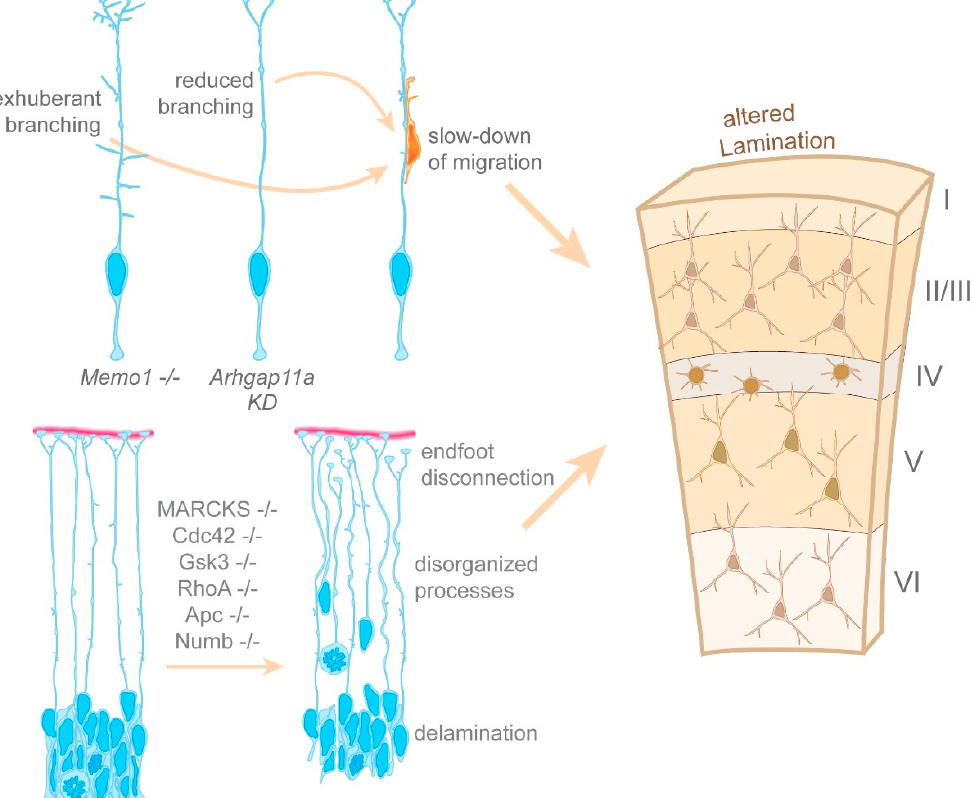
Figure 5. Pathways regulating radial glia morphology and the shape of the basal process. Memo1 and Arhgap11a regulate branching of the radial glia basal process. Knockout of Memo1 and knockdown of Arhgap11a lead to exuberant, and decreased branching of the basal process, respectively. Ultimately, compromised basal process branching slows down neuronal migration and leads to misplaced neurons in the cortex. The depletion of proteins such as RhoA, Cdc42, Gsk3, Apc, Numb and MARCKS leads to radial glia endfoot disconnection, the disorganization of basal processes, and radial glia delamination from the apical surface. In these conditions, impaired radial glia morphology is linked with altered lamination of the cortex.